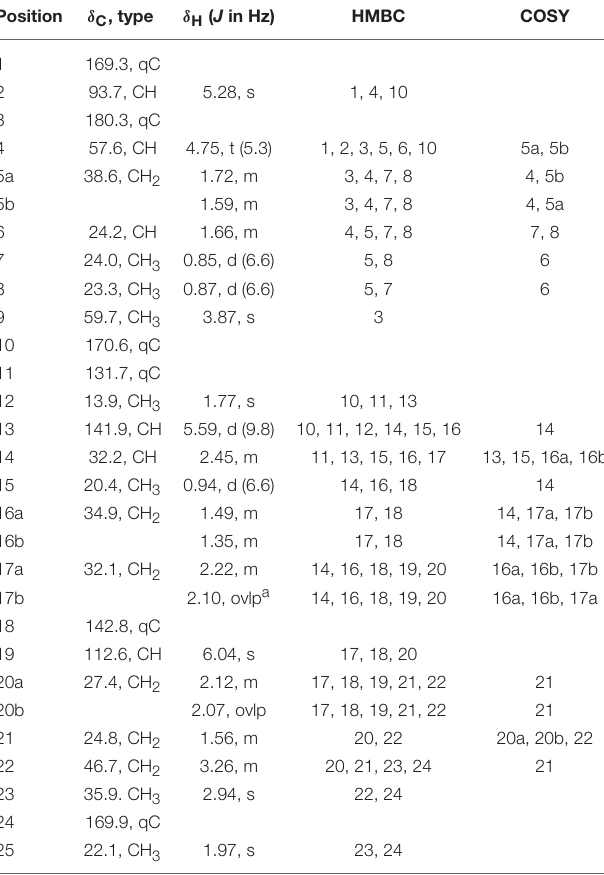
TABLE 1 | NMR data for Smenamide C ( 1 ) Z -conformer (800 MHz for 1 H NMR; 200 MHz for 13 C NMR, DMSO). Position δ C ,